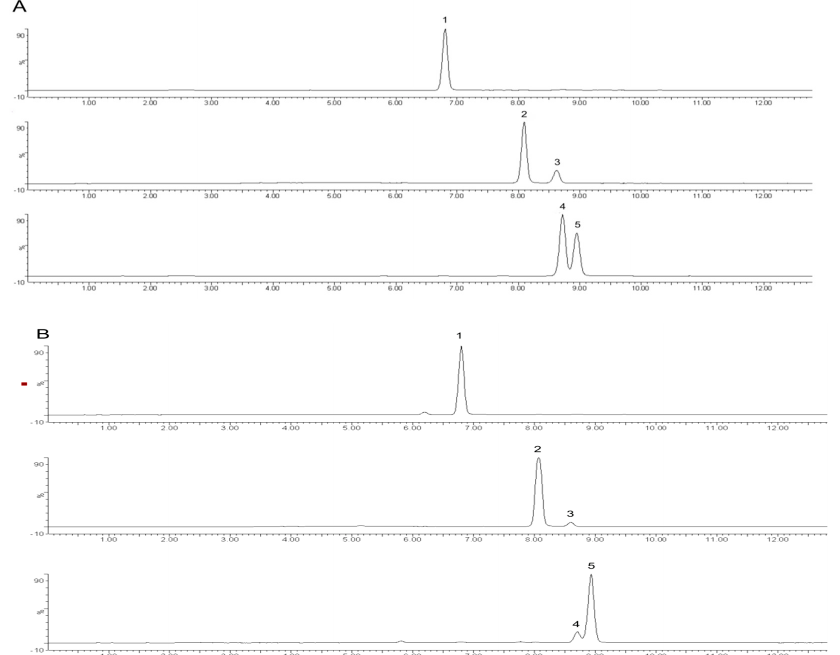
Figure 2. Multichannel single-ion monitoring chromatograms of the LC–MS of the PMP derivatives of mixed standard monosaccharides ( A ) and PPL-1 ( B ). Peaks: 1, galacturonic acid; 2, glucose; 3, galactose; 4, xylose; 5, arabinose.